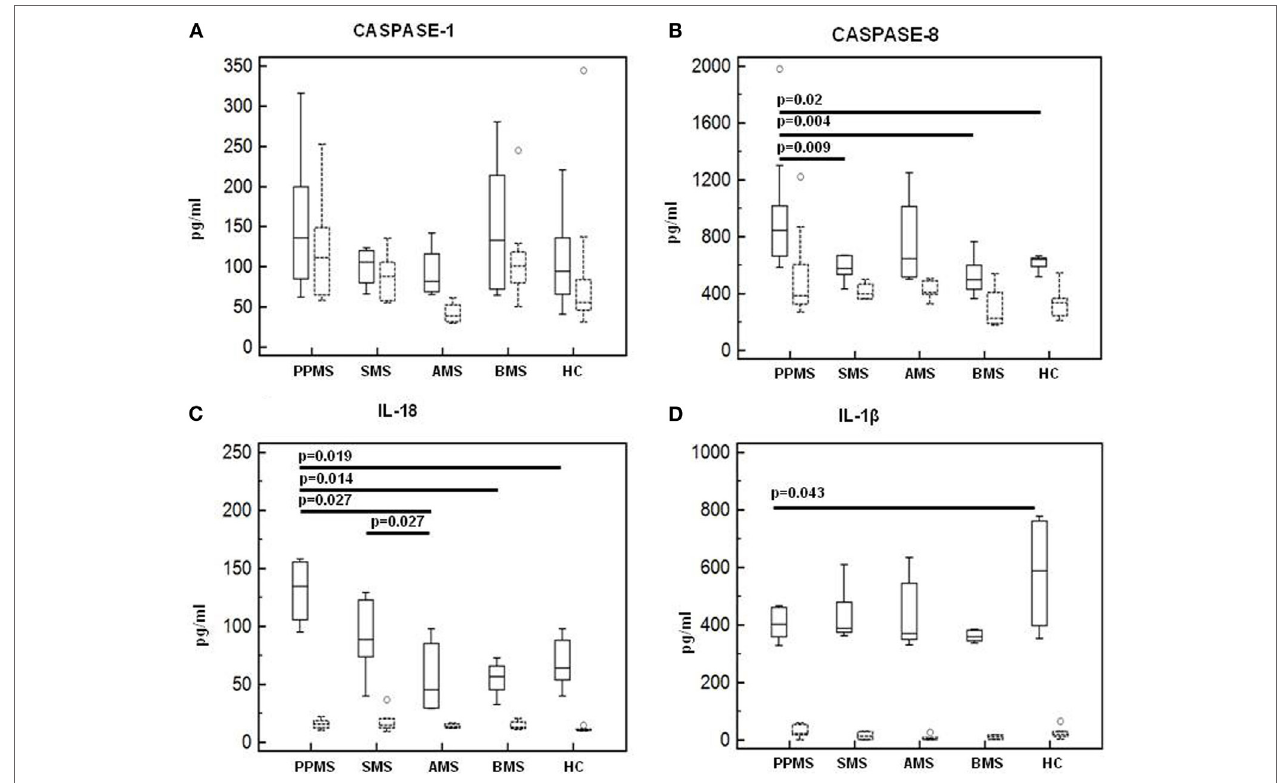
FigUre 8 | Caspase-1, Caspase-8, and inflammasome effector cytokines production in lipopolysaccharide (LPS)-primed and monosodium urate crystals (MSU)-stimulated-PBMCs. Caspase-1 (a) , Caspase-8 (B) , interleukin-18 (c) , and IL-1 β (D) production was assessed by multiplex ELISA in supernatants of unstimulated and LPS-primed and MSU-stimulated cells of primary progressive (PP, n = 11), acute relapsing-remitting (A, n = 10), stable relapsing-remitting (S, n = 10), or benign (B, n = 10) multiple sclerosis (MS) patients and healthy controls (HC, n = 10). Summary results are shown in the bar graphs. Solid lines represent supernatants from LPS-primed and MSU-stimulated cells. Dashed lines indicate supernatants from unstimulated cells. The boxes stretch from the 25 to the 75 percentile; the line across the boxes indicates the median values; the lines stretching from the boxes indicate extreme values.